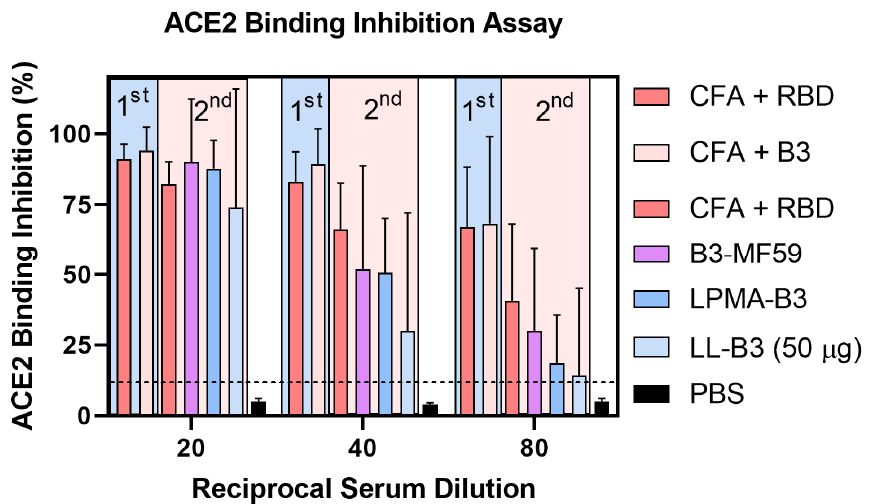
Figure 5. Competitive ELISA binding inhibition assays of immune sera, where ability of antibodies from sera of immunized mice to inhibit interaction between ACE2 and RBD of spike protein was measured. The inhibition efficacies of antibodies collected from sera of mice immunized in the antigen screening study are highlighted in blue, while ones from the adjuvant screening study are highlighted in light red. The mice sera have been diluted 20, 40, and 80 times.